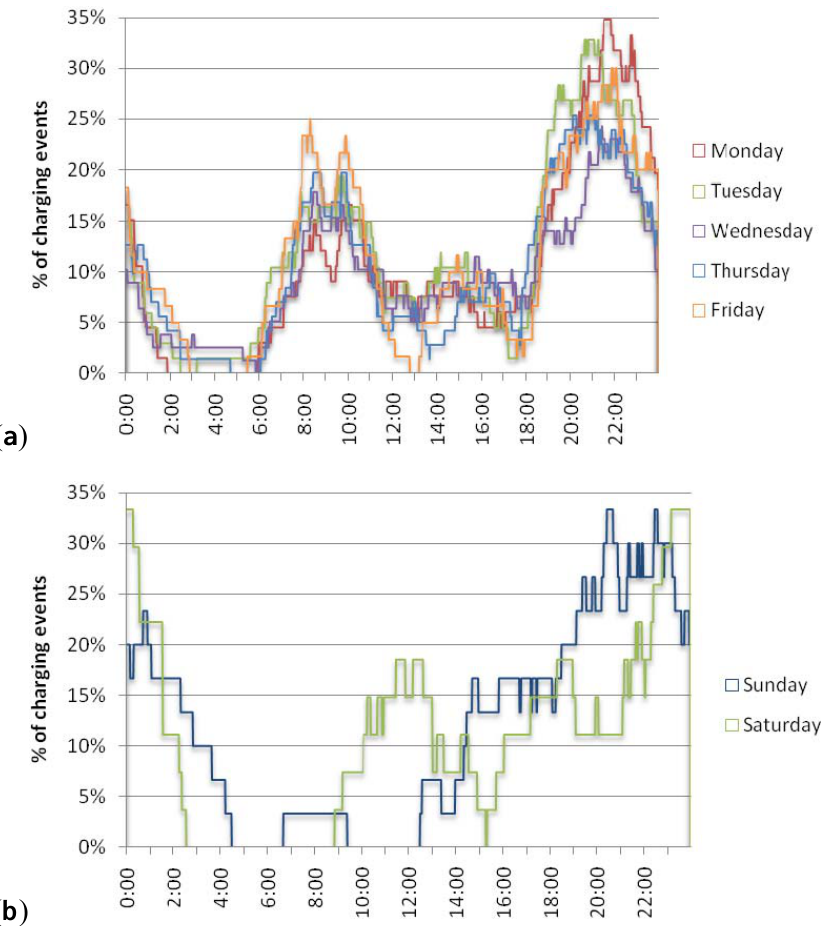
Figure 2. Percentage of charging events by time and day: ( a ) weekdays and ( b )